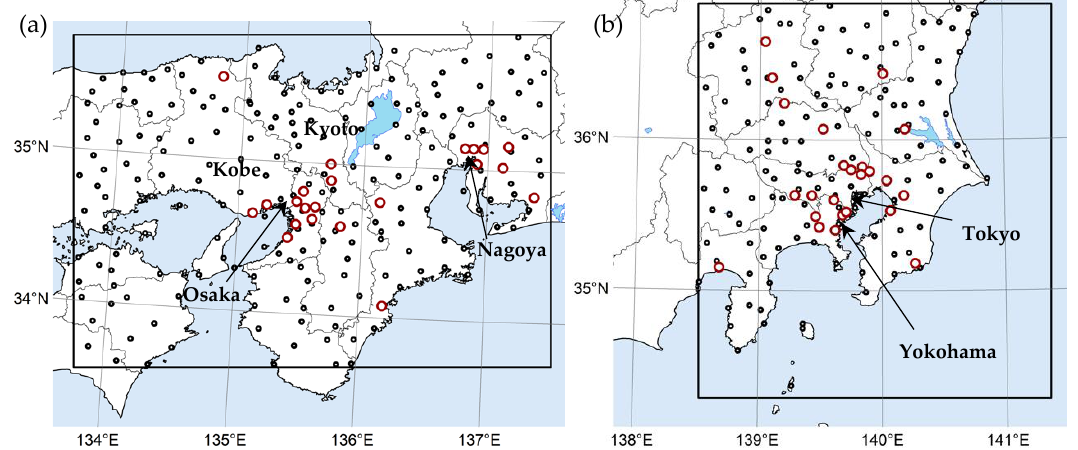
Figure 1. Finest model domains for J-STREAM, d03 ( a ) and d04 ( b ). d03 covers major city clusters located in western Japan including Osaka, Kobe, Kyoto, and Nagoya. d04 covers the Tokyo metropolitan area. The red circles indicate the locations of ambient air pollution monitoring stations (AAPMSs). The black circles indicate the locations of the meteorological observation stations of the Japan Meteorological Agency (JMA).